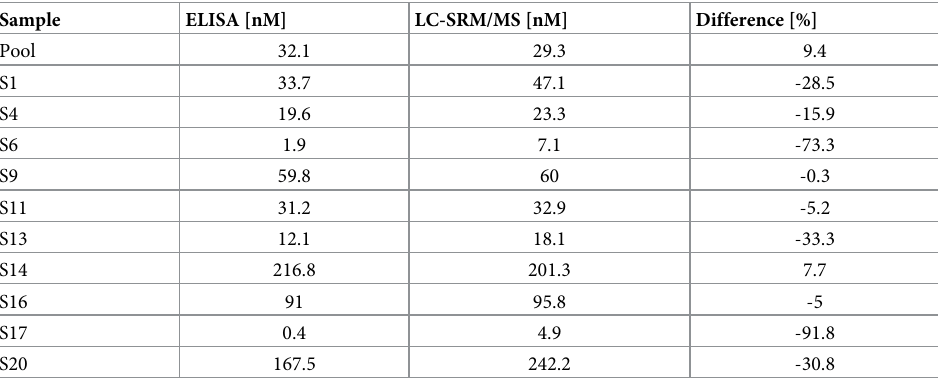
Table 3. Quantification results of apo(a) from ELISA and